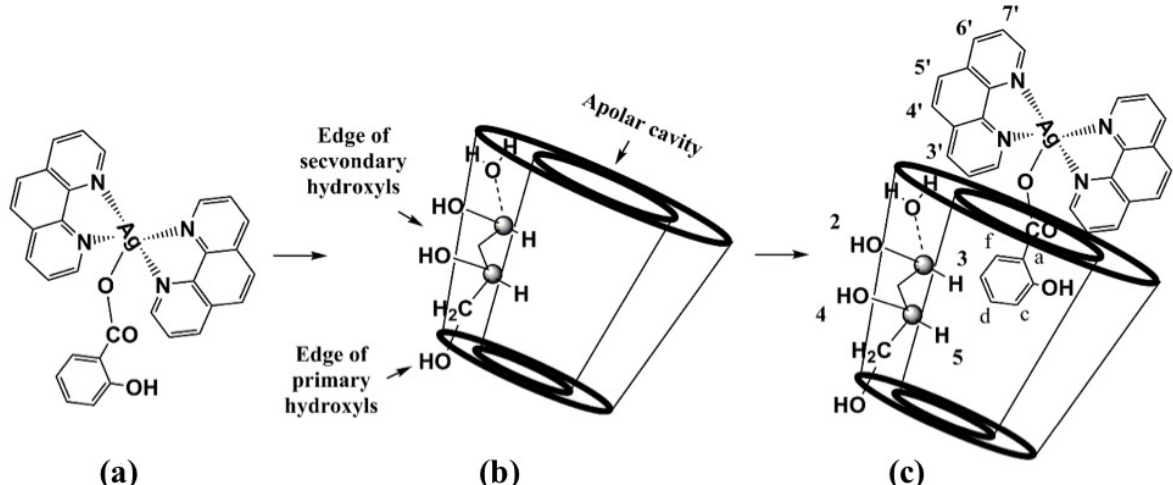
Figure 4. Schem of partial inclusion of bis(1,10-phenanthroline)silver(I) salicylate (a) in apolar cavity of β-cyclodextrin (b) producing the partial inclusion complex